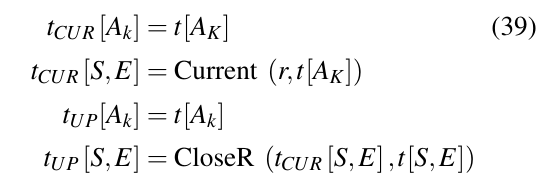
Fig. 4. Allen’s relations for two crisp time intervals I and J . Note that the crisp time interval I is fixed and the different positions of the interval J illustrate the Allen’s